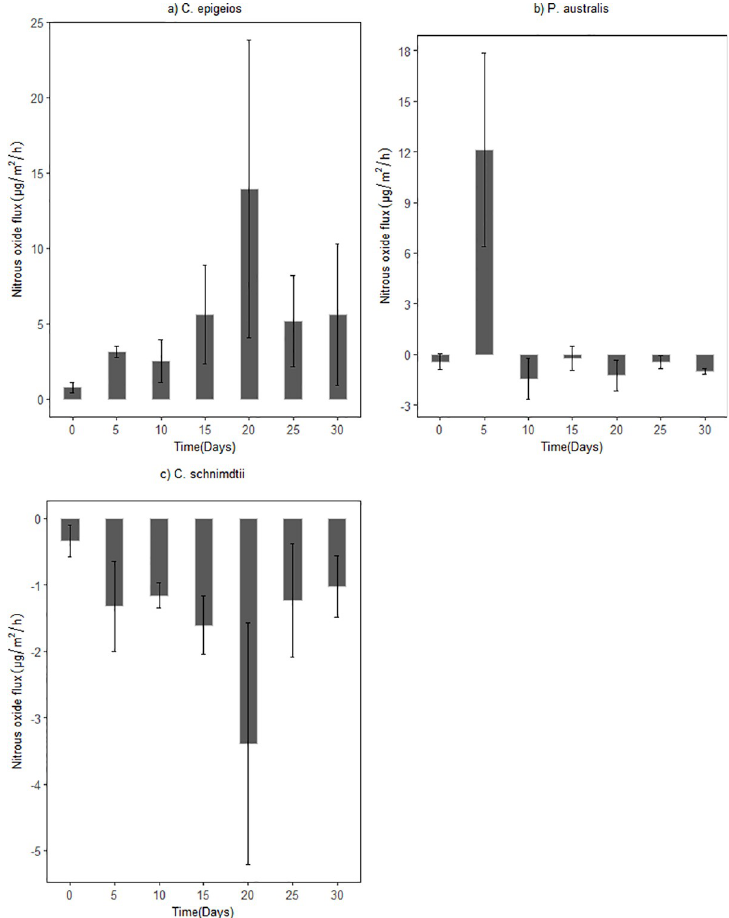
Fig 10. Fluxes of N 2 O from soil in laboratory setup from Qixing River Wetland National Nature Reserve incubated for 30 days. (a) Soil from site dominated by C . epigeios , (b) soil from site dominated by P . australis , (c) soil from site dominated by C . schnimdtii . Error bars represent standard error of the mean.